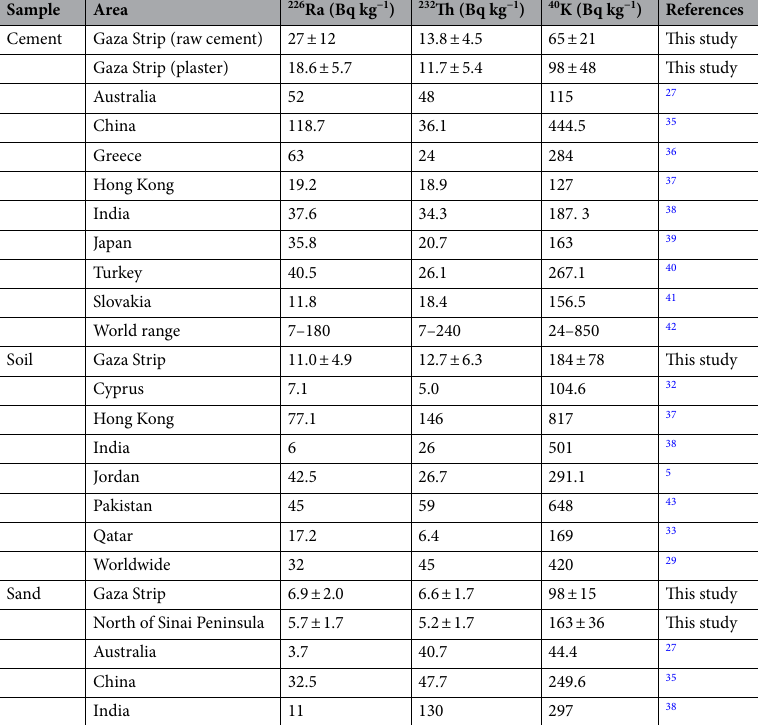
Table 3. Comparison of activity concentration of 226 Ra, 232 Th, 40 K in cements, soils and sands among various areas in the